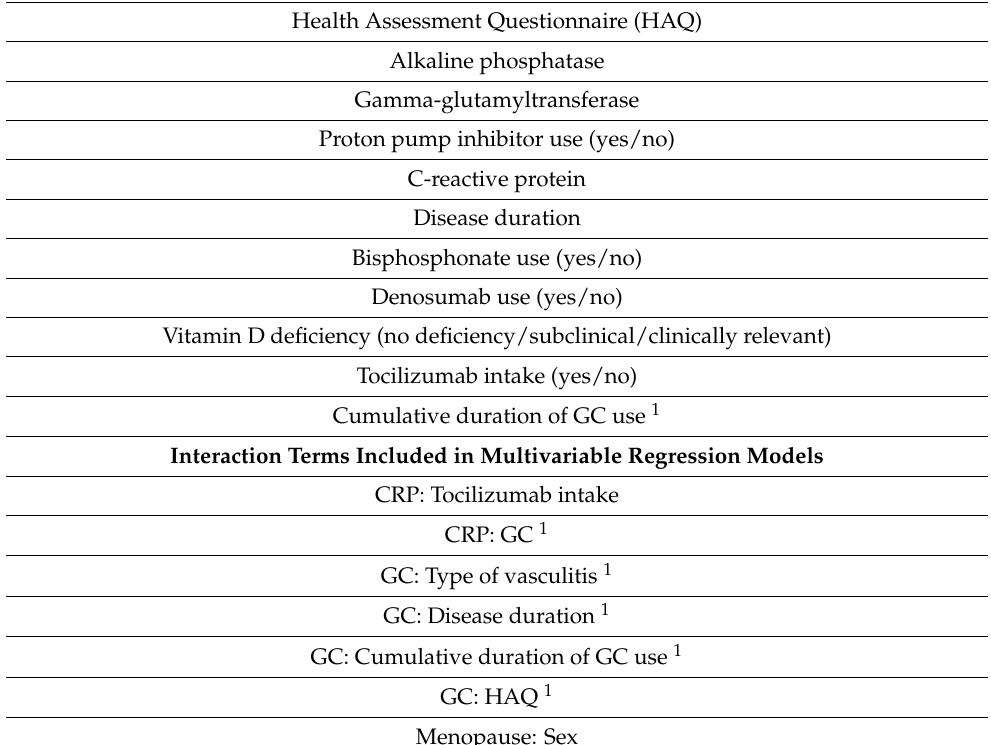
Table 2. Cont. Potential Confounders Included in Multivariable Regression